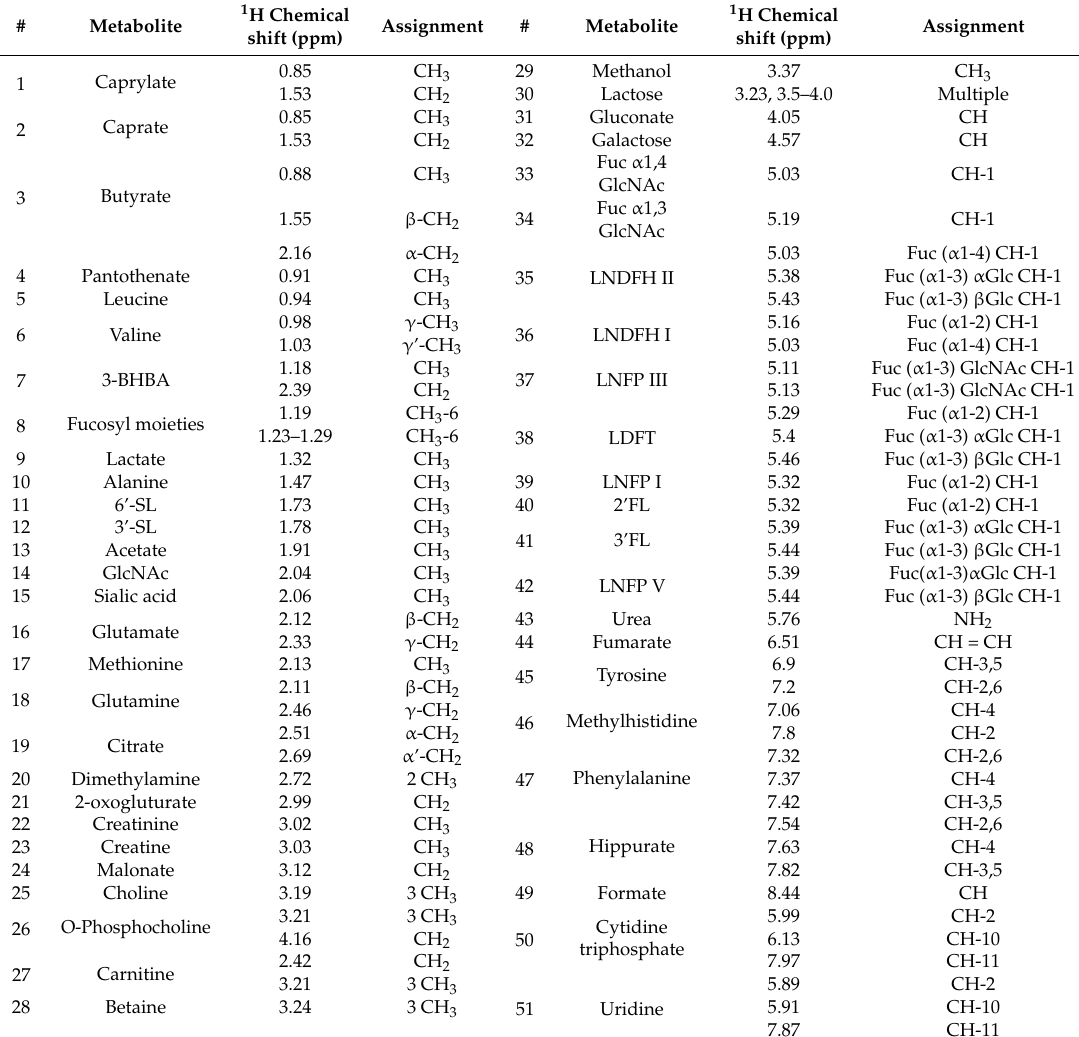
Table 3. List of metabolites in human milk with chemical shifts in ppm from internal TSP standard and assignment of